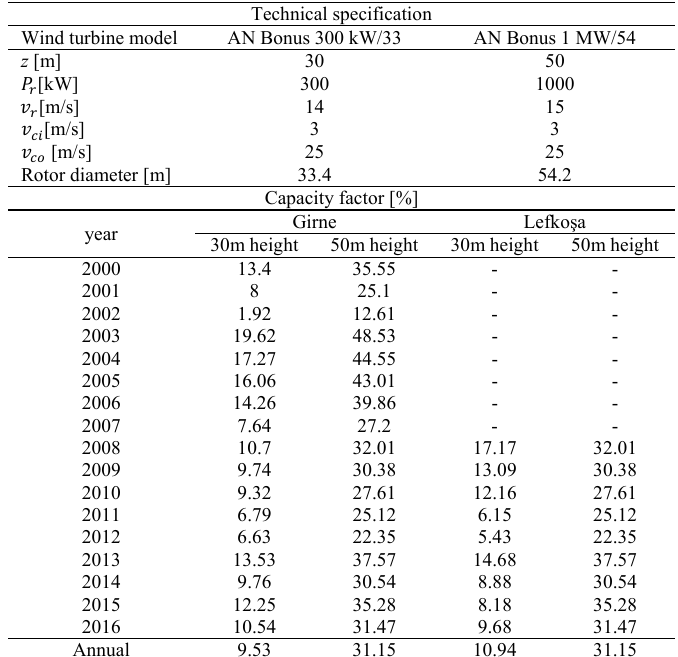
Table 6: Technical specification and the capacity factor of the selected wind turbine based on hub height Technical specification Wind turbine model